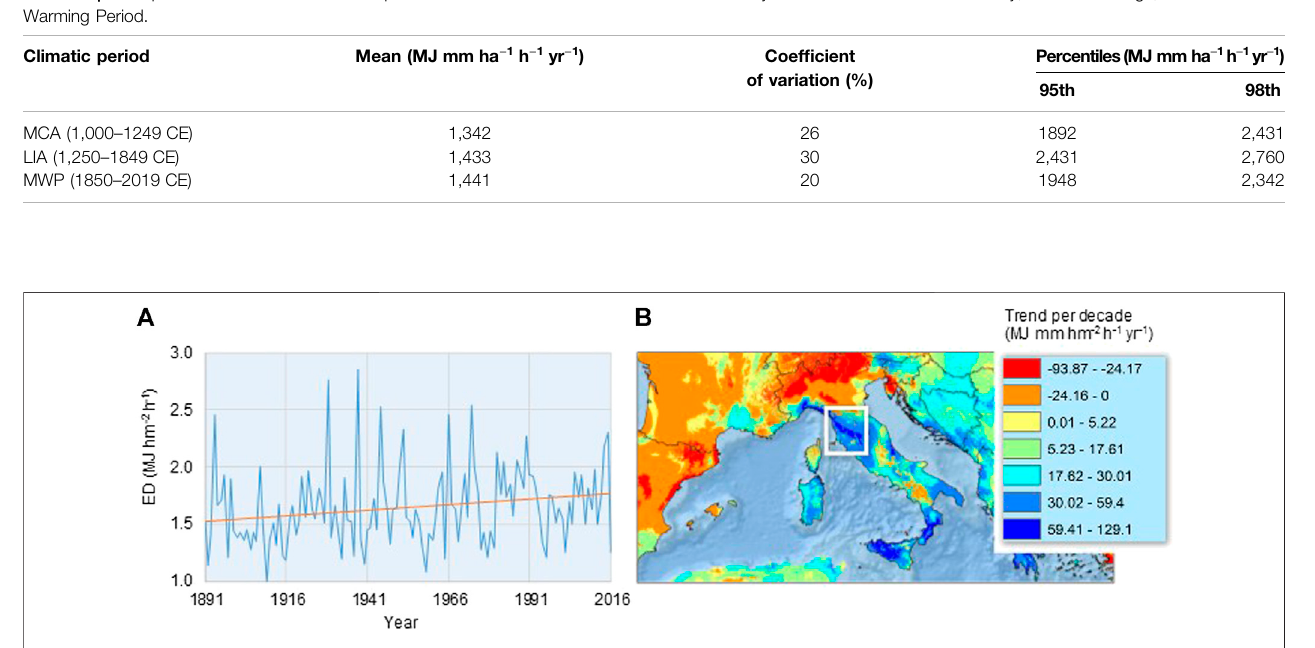
Frontiers in Earth Science |